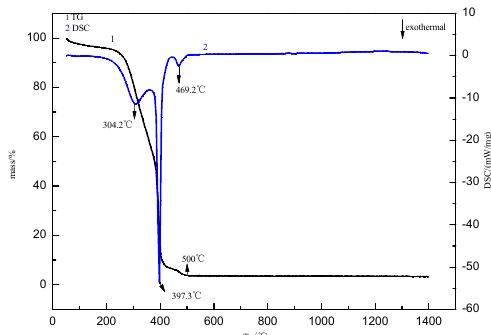
Figure 2. Thermogravimetry-differential scanning calorimetry (TG-DSC) curve of Mg 2+ loaded with carbon microspheres.